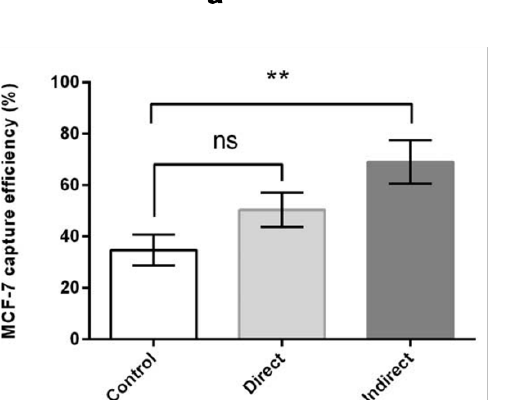
Figure 6. ( a ) Comparison of capture efficiencies of MCF-7 cells by control, direct, and indirect antibody immobilization strategies of APTES-modified ring electrode QCR (ns = not significant p > 0.05, ** = very significant 0.001 > p > 0.01). ( b ) Representation of direct and indirect anti-EpCAM